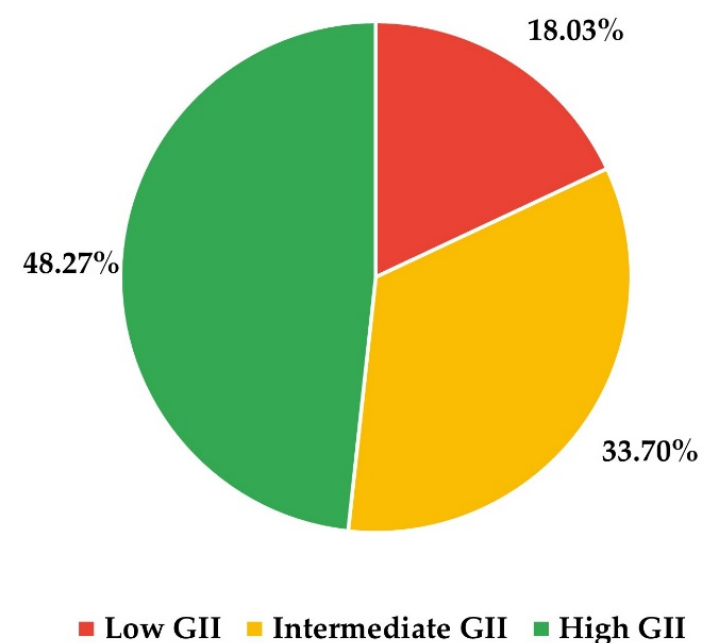
Figure 2. Distribution of the participants in the sample by GII area.